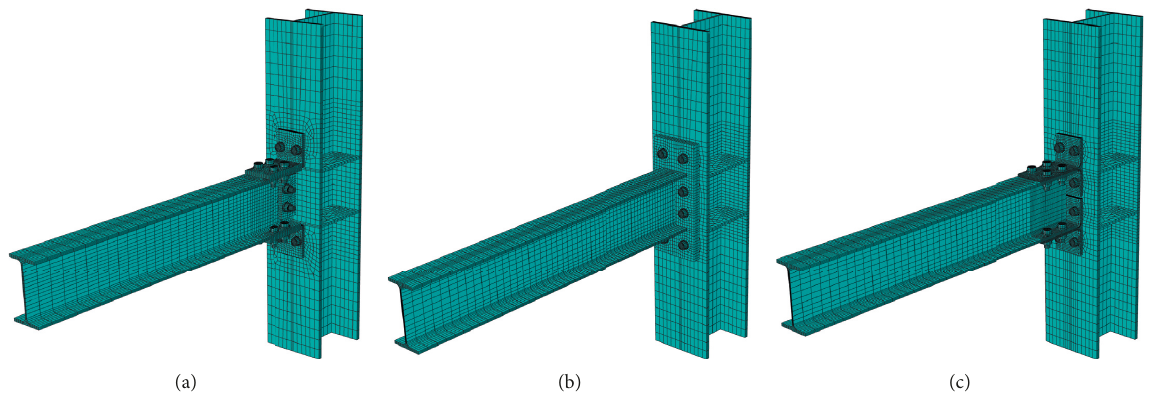
Figure 7: Loading scheme.